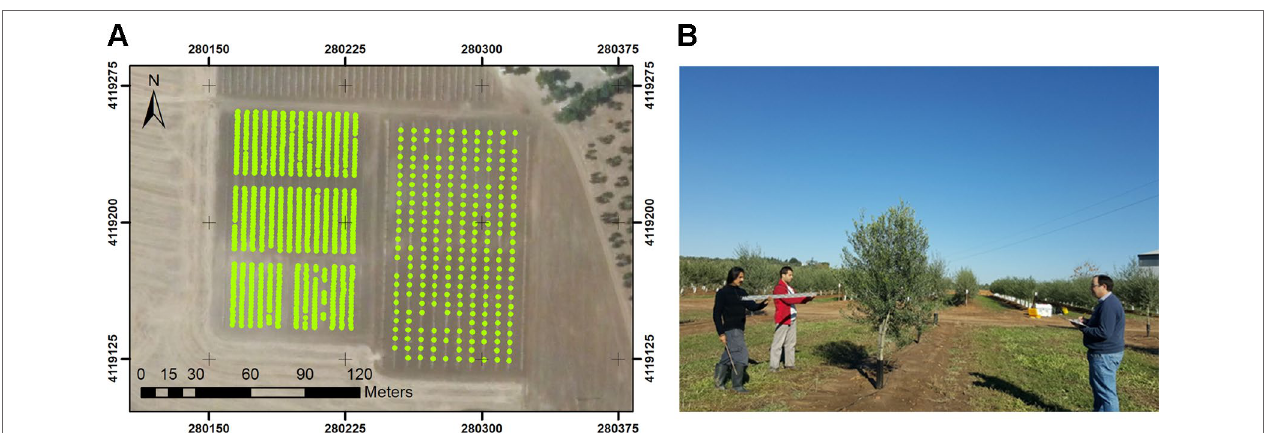
FIgUrE 5 | Experimental set for validation: (A) point grid for DSM validation in both the hedgerow and the intensive trial; (B) manual measurements of olive crown width. The individuals in this manuscript have given written informed consent to publish these case details.